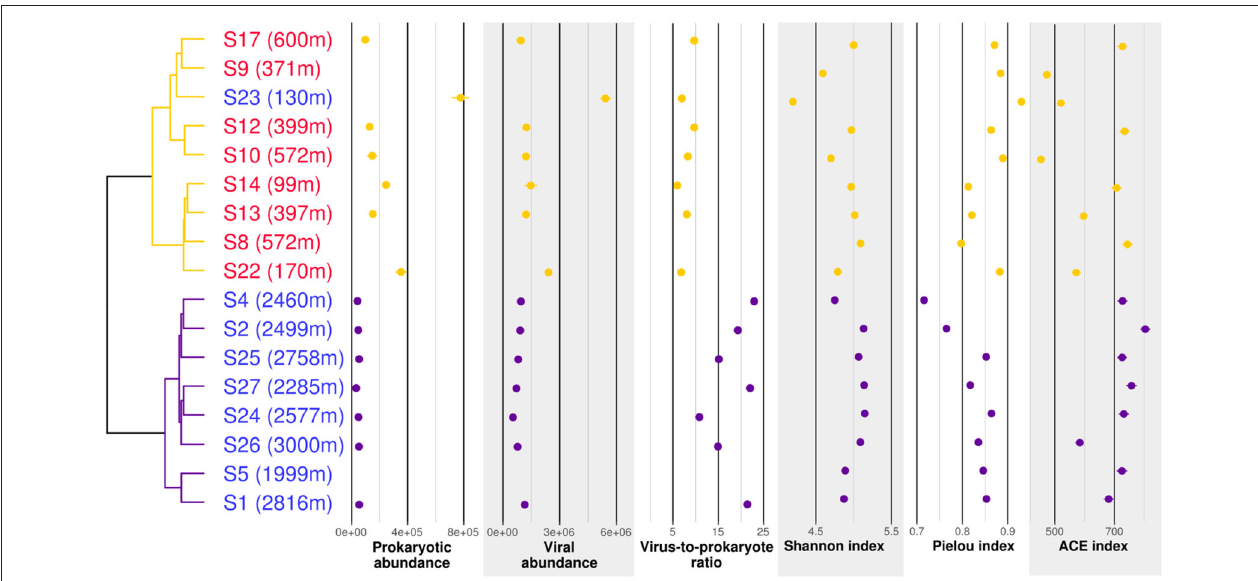
FIGURE 6 | Cluster analysis, counts and biodiversity indices of the samples used for g23 profiling. The dendrogram is based on Bray-Curtis dissimilarities of g23 OTU distributions. Samples written in red were taken in plumes while samples written in blue were taken in background water. Abundances are given in counts per milliliter. Counts were not available for S9, S8, and S5. Purple, group V1; orange, group V2.